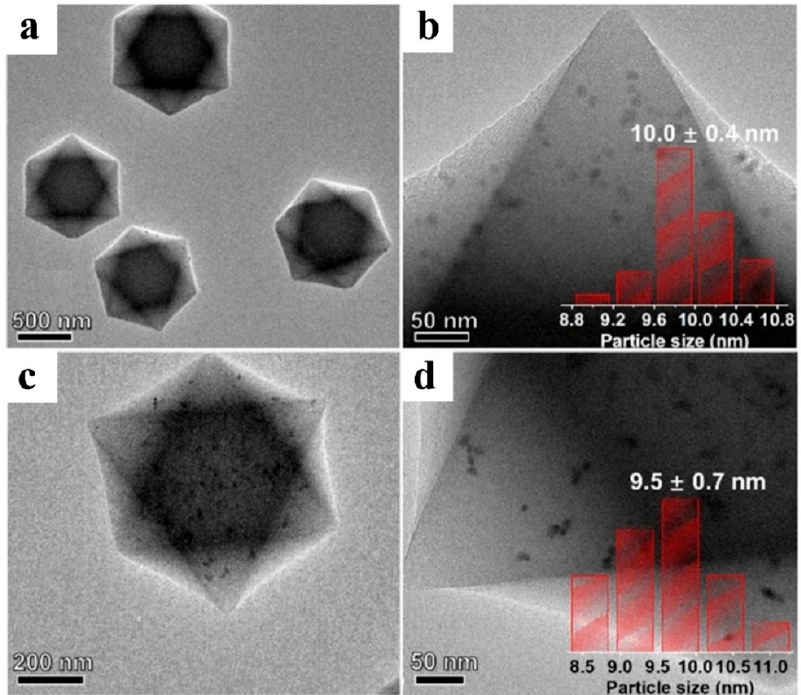
Figure 6. The TEM images of ( a , b ) Ni 2 P@UiO-66-NH 2 (the inset is the size distribution of Ni 2 P NPs) and ( c , d ) Pt@UiO-66-NH 2 (the inset is the size distribution of Pt NPs). Reproduced with permission from Ref. [69].